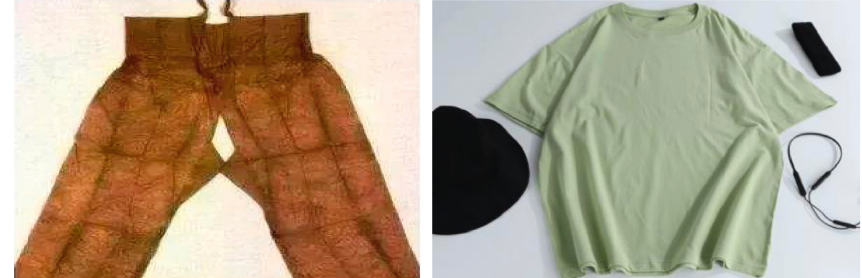
Figure 2: Development and change of clothing materials.